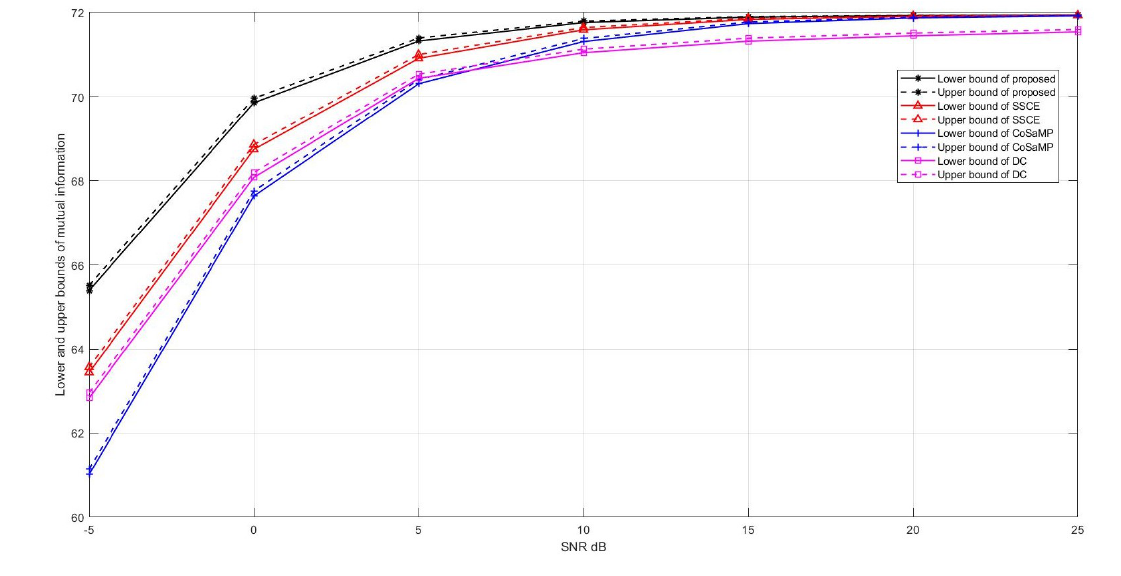
Figure 9. Lower and upper bounds of mutual information versus